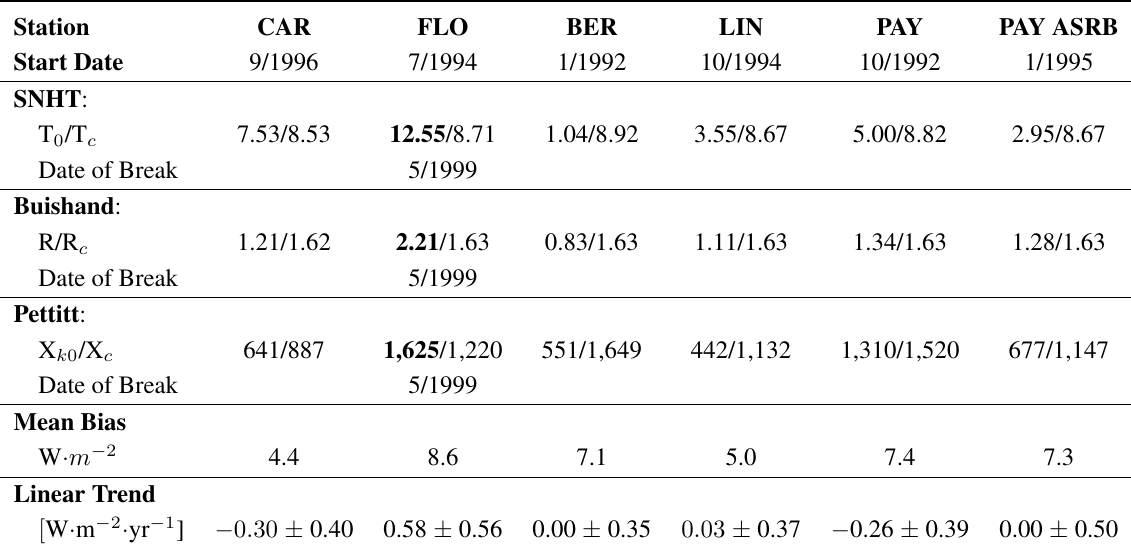
Table 3. Results of the relative homogeneity tests of the time series from the ERA-Interim dataset at the grid points nearest to corresponding BSRN surface stations. Also given are mean absolute bias and the linear trend of the difference time